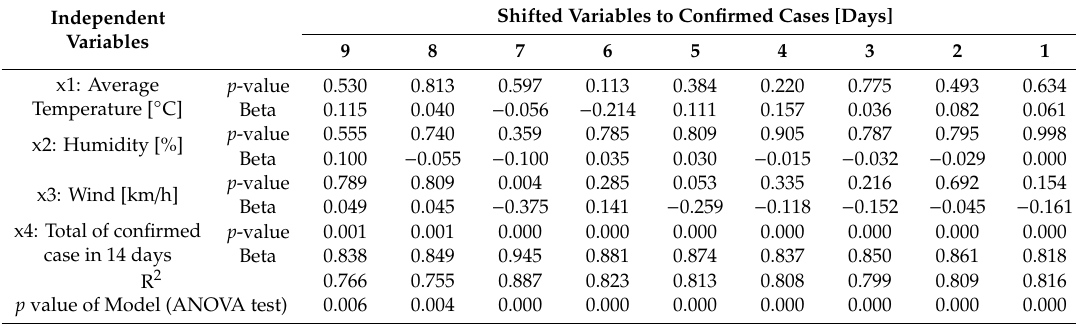
Table 4. The result of multivariate linear regression, Veneto